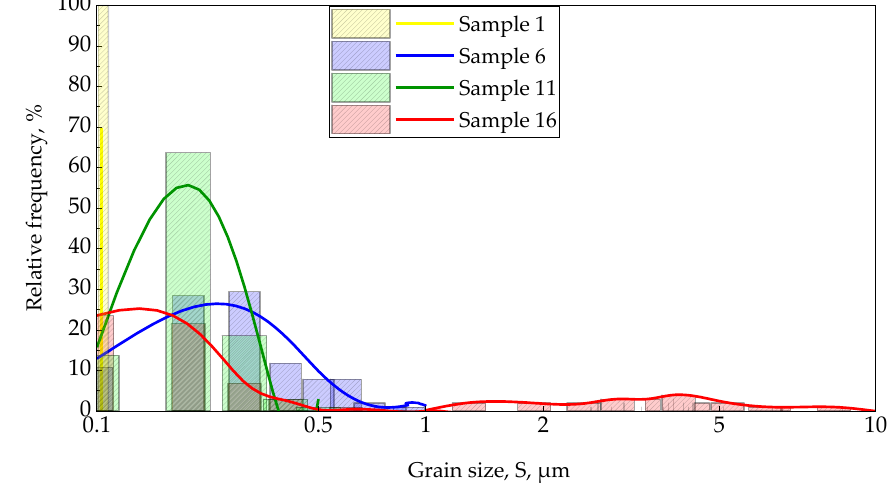
Figure 7. Plot of relative frequency versus grain size,